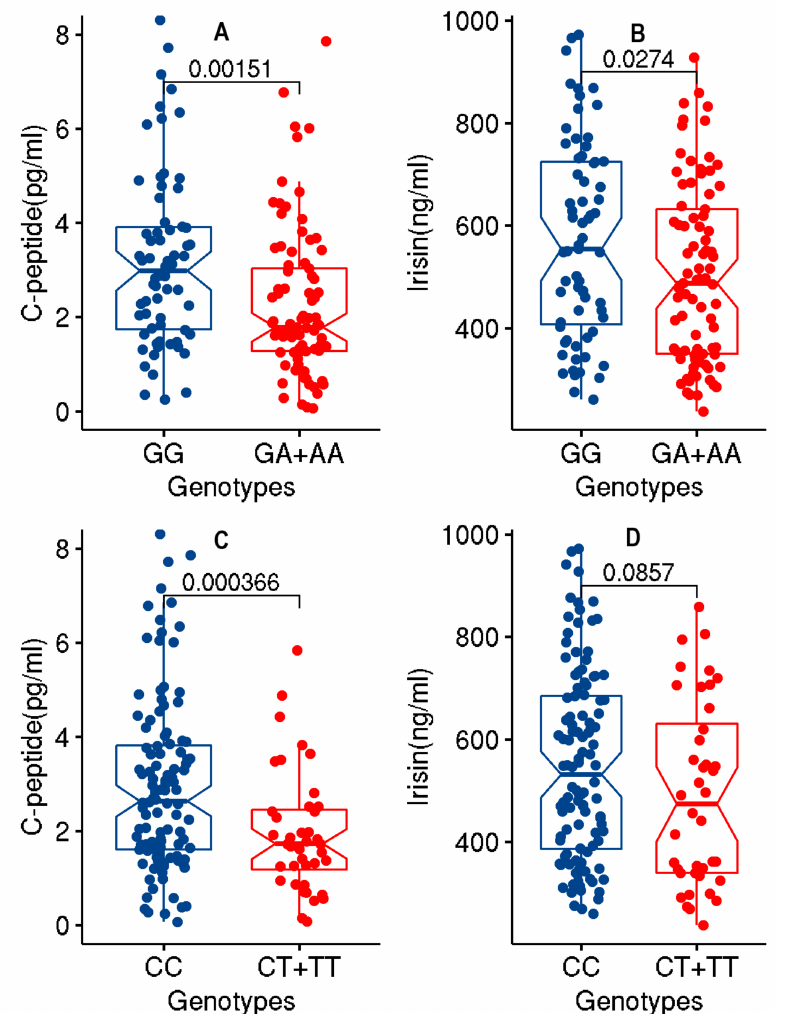
Figure 1. Box plots displaying data distribution for the phenotype traits of c-peptide and irisin in individuals with genotypes (GA + AA) containing the effect allele or genotypes (GG) homozygous for reference allele at variant rs1748197 (Figure 1A,B); and in individuals with genotypes (CT + TT) containing the effect allele or genotypes (CC) homozygous for reference allele at variant rs12130333 (Figure 1C,D).